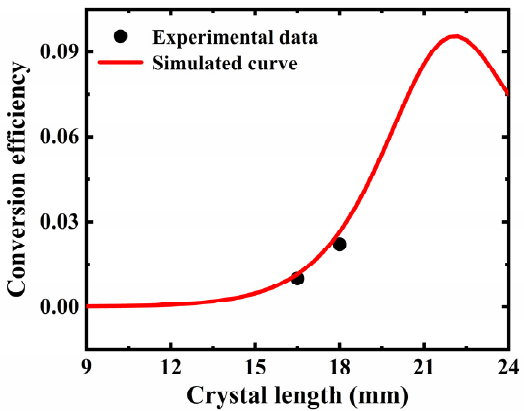
Figure 4. Simulated optical-optical conversion efficiency from 1.064 to 6.45 μ m versus crystal length at mixed pump pulse energy of 58 mJ. The black dots represent the experimental data at the BGSe crystal lengths of 16.5 and 18 mm, respectively.